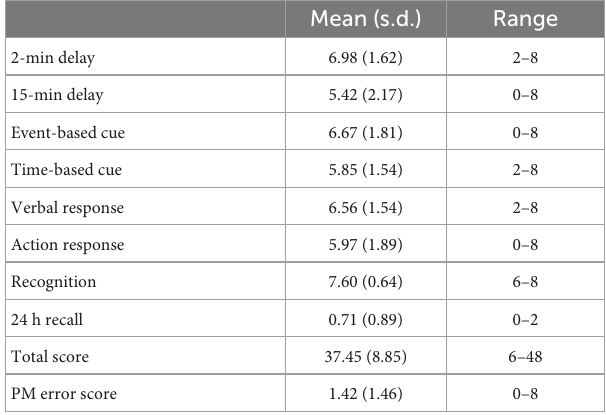
TABLE 2 Spanish MIST performance n =